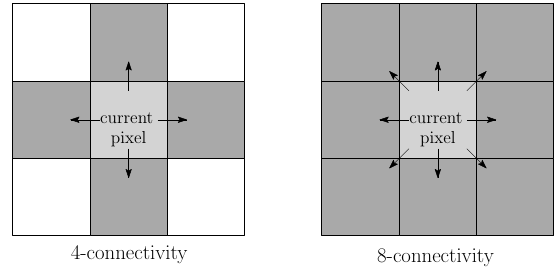
Figure 2. 4- versus 8-neighbourhood of a pixel